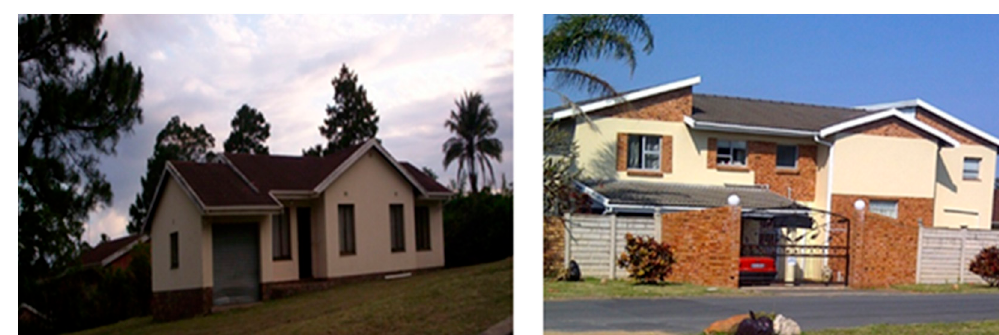
Figure 4. Types of houses in the urban settlement.